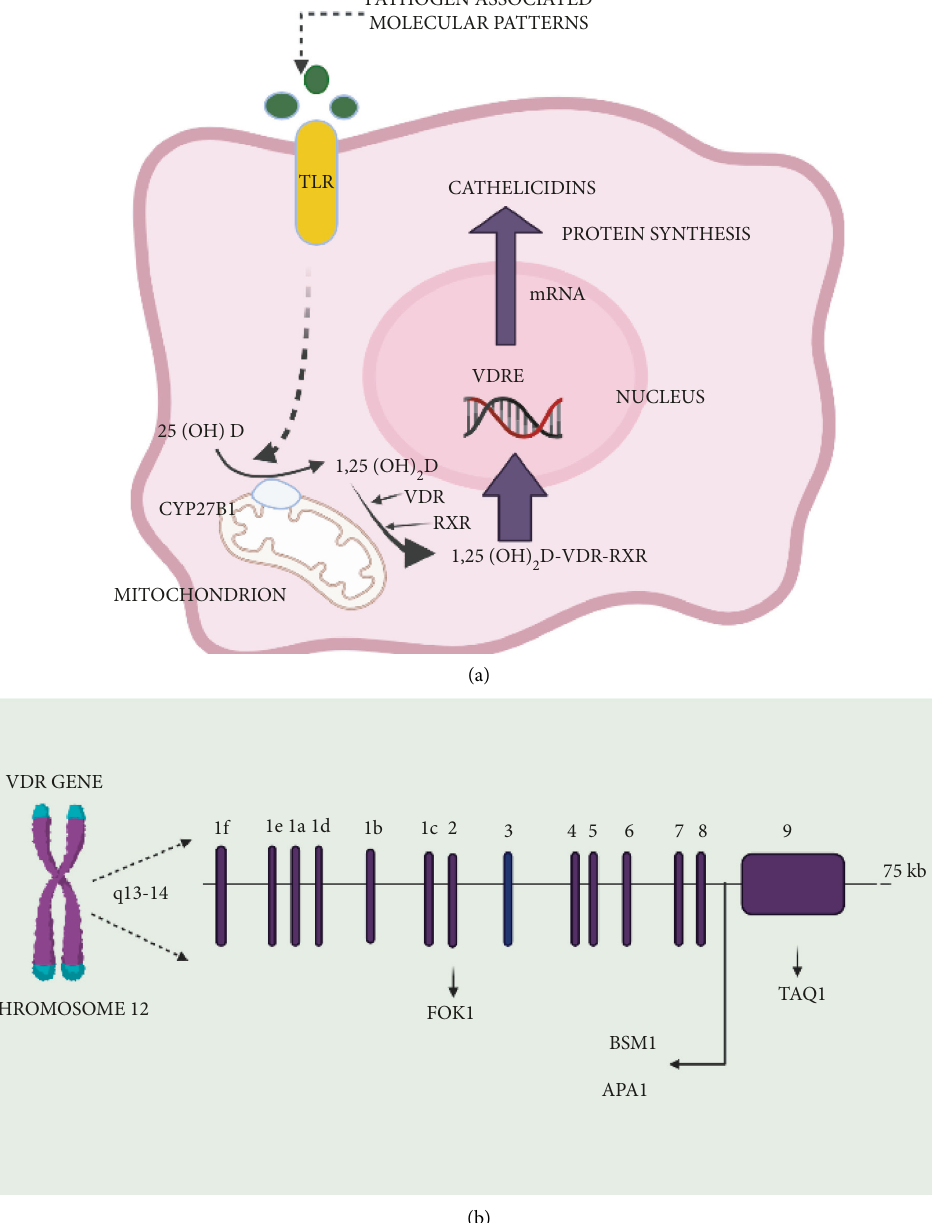
Figure 1: (a) Vitamin D cathelicidin pathway (TLR2 vitamin D LL-37). (b) Locations of various single nucleotide polymorphisms in VDR (created by